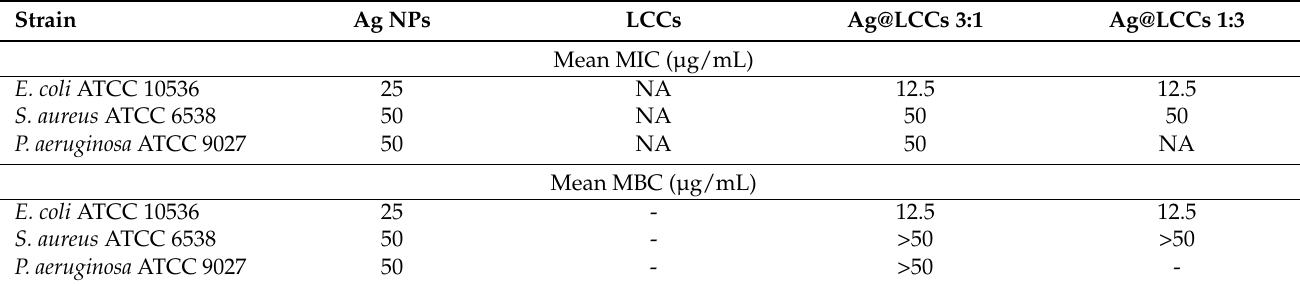
Table 3. MICs and MBCs of Ag NPs, LCCs, and Ag@LCCs (expressed as Ag NPs µg/mL) against Gram-positive and Gram-negative